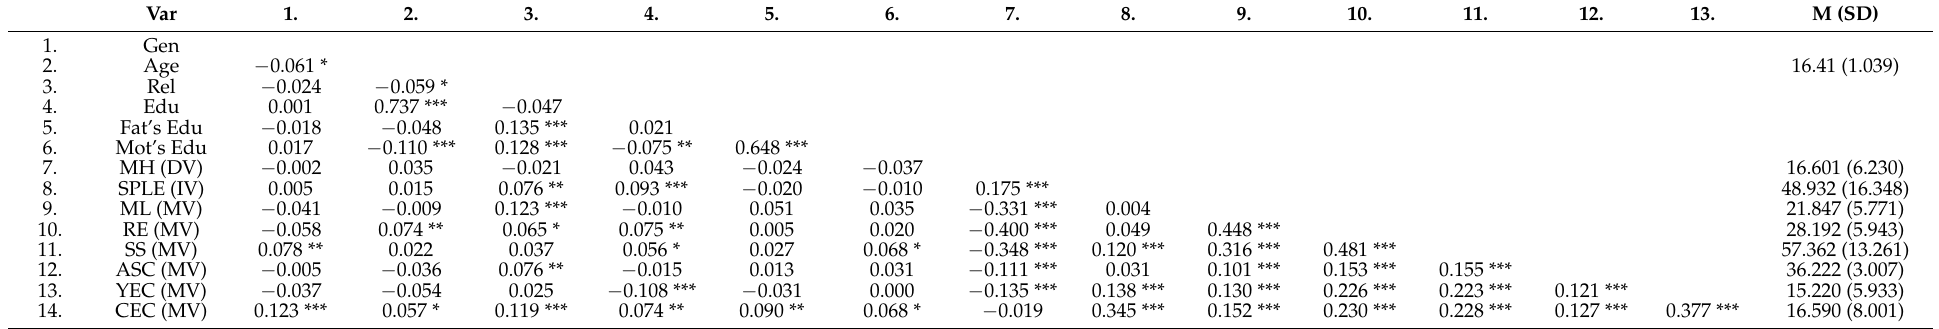
Table 2. Correlations among demographic variables, criterion variables, predictor variables, and moderating variables with means and standard deviations ( n = 1330).